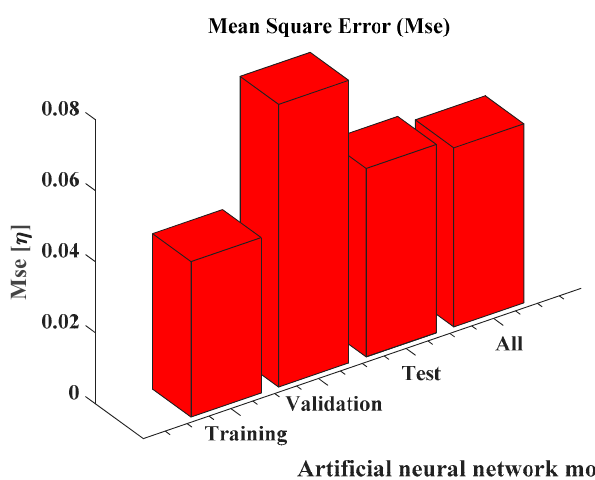
Figure 12. Values of mean squared error (MSE) of training, validation, test, and all.